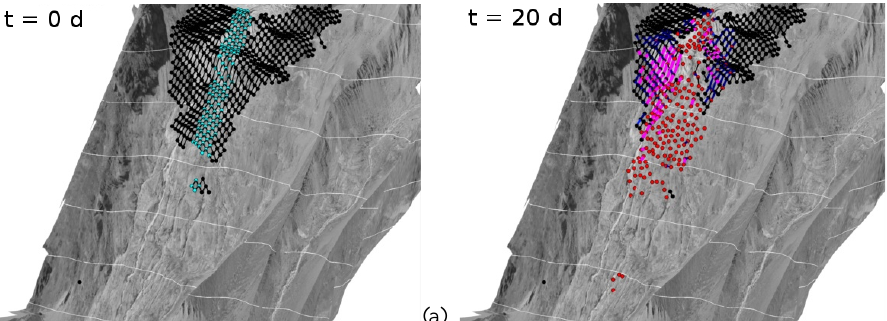
Fig. 11. (a) Blue blocks indicate where the friction coefficient was decreased. (b) Snapshot at the end of the run (same legend as in Fig. 10) where the instability results in a localized break-off with a triangular